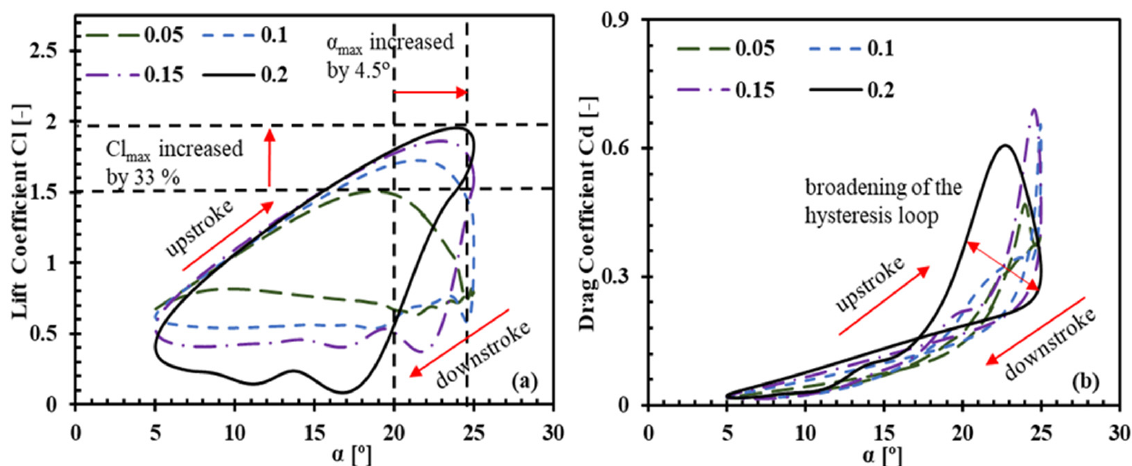
Figure 10. Aerodynamic coefficients of ( a ) lift and ( b ) drag for various reduced frequencies (k = 0.05, 0.10, 0.15, and 0.20).